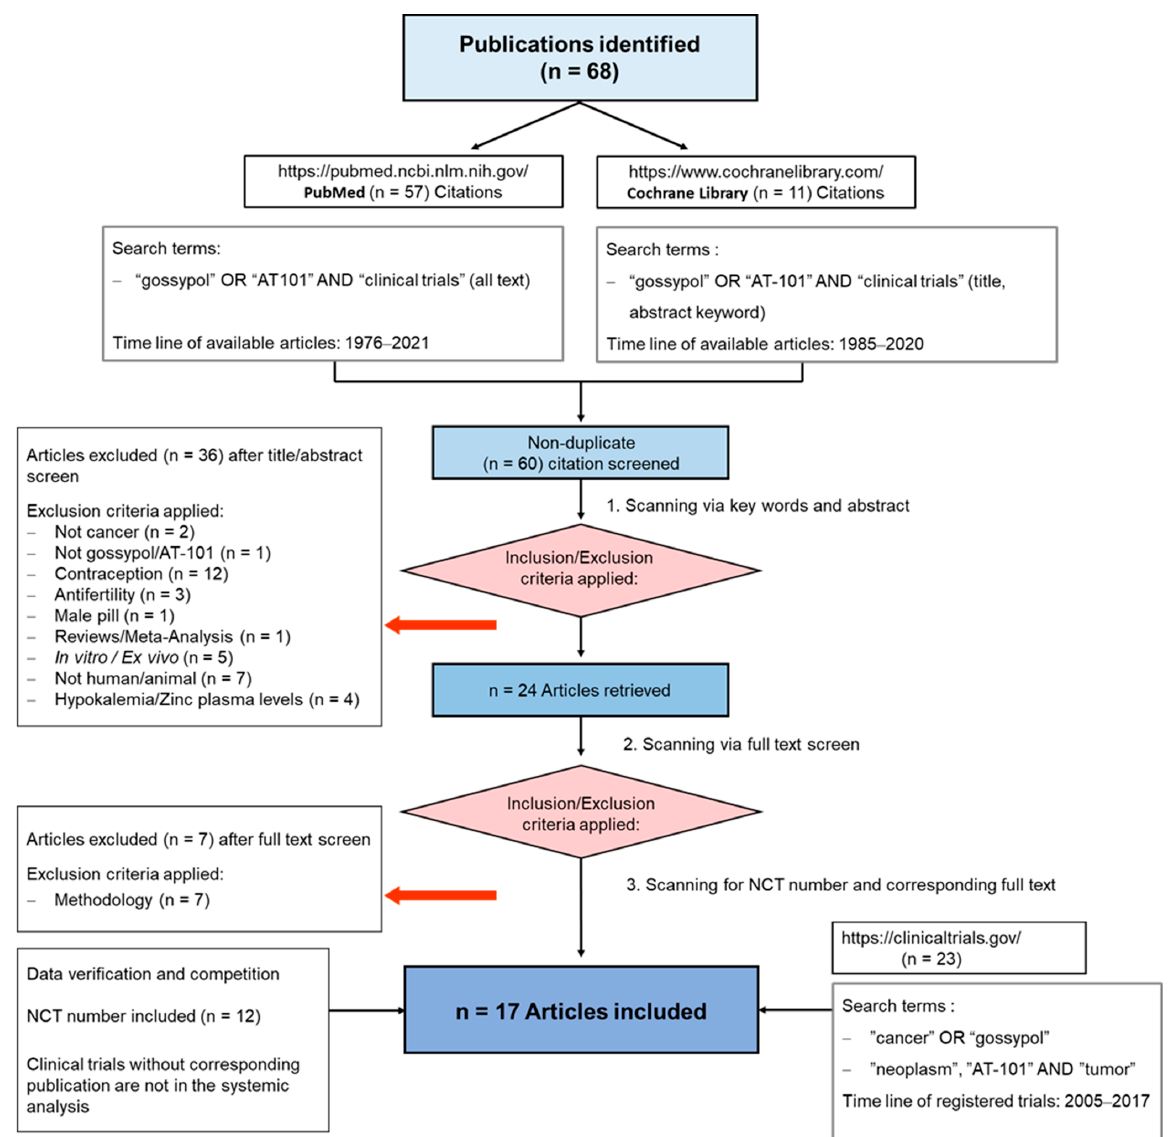
Figure 2. PRISMA Flow Diagram. The diagram illustrates the passage of information through the various phases of this review. It displays the number of studies included and excluded, as well as the criteria for the respective exclusions. The data included in this systematic review were collected from August to September 2021 and reviewed during September 2021.